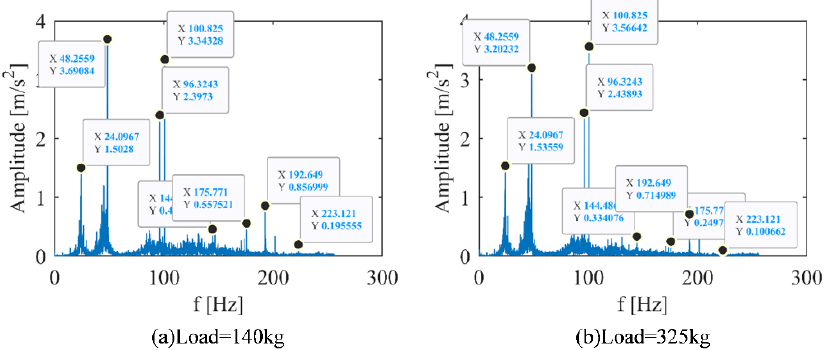
Figure 7. Vibration demodulation diagram under different operating conditions (2.4m/s). ( a ) Mo- tor with up-drive condition. ( b ) Motor with down-drive condition.